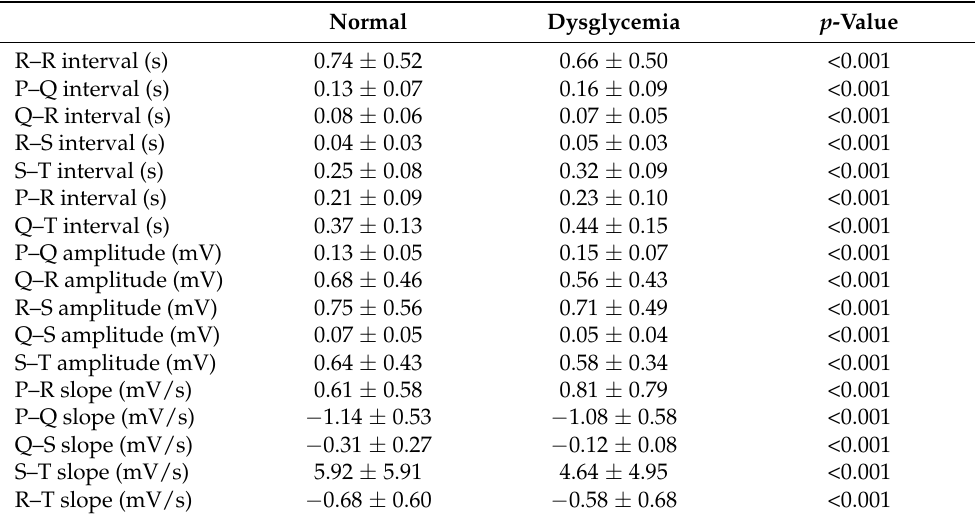
Table 2. Statistical differences of selected ECG features between normal and dysglycemia. Normal Dysglycemia p